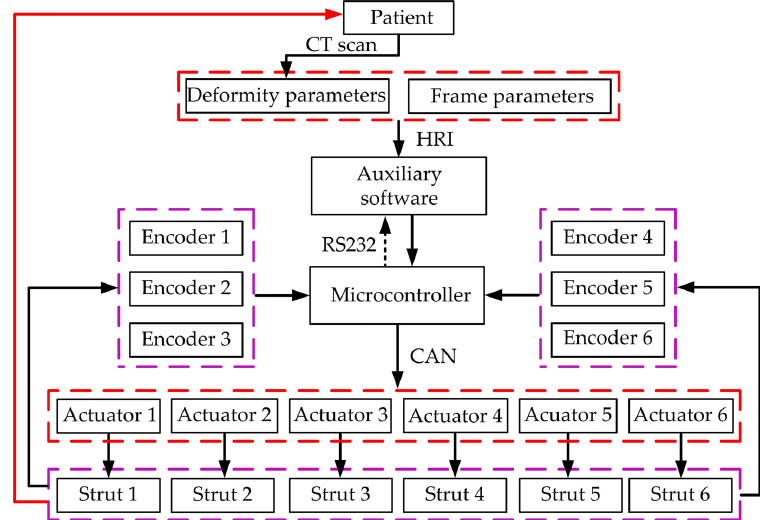
Figure 4. The hardware composition of the electromechanical system.